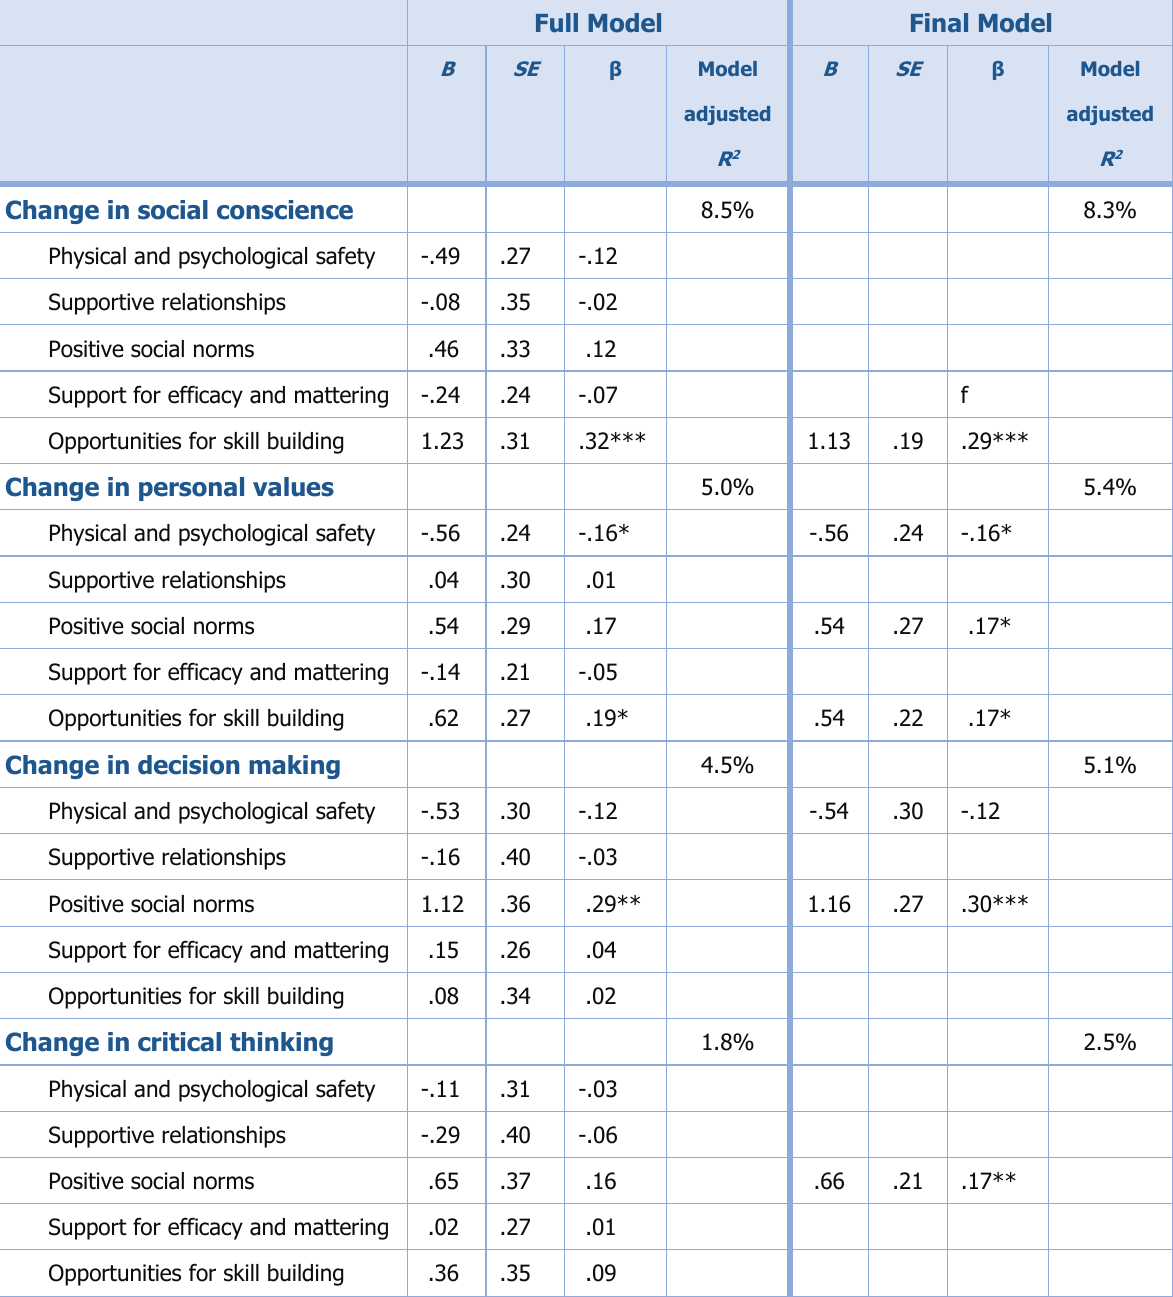
Table 3. Backward-Elimination Multiple Linear Regression Full and Final Models With Four Core Competencies as Dependent